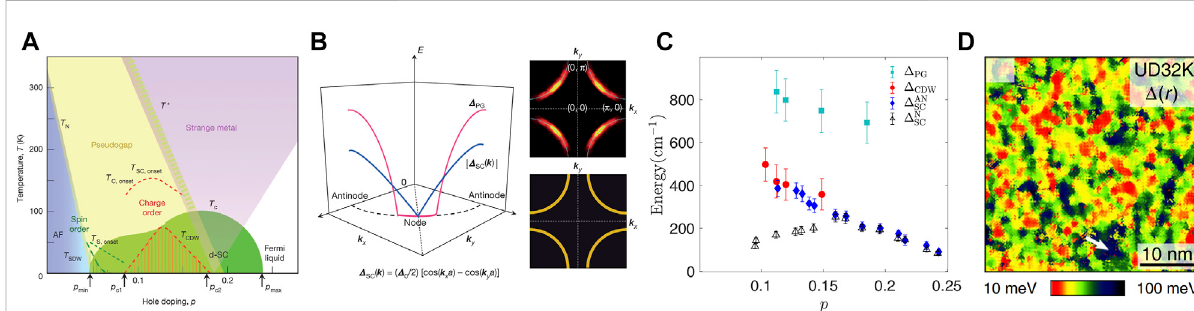
FIGURE 1 Pseudogap phenomena in cuprates. (A) The complex phase diagram for hole-doped cuprates [1], which shows the pseudogap phase and its associations with spin,charge, and superconducting orders. (B) Gapfunctions,Fermiarcs,and Fermisurface[1].Once thepseudogap( Δ PG intheleft panel) sets in, the antinodal regions of the Fermi surface near the Brillouin zone edge are gapped out, giving rise to Fermi arcs (top right). (C) The doping dependencies of the pseudogap, the antinodal superconducting, and the CDW energy scales in HgBa 2 CuO 4+ δ with data from Ref. [11]. (D) The local spectral gap of an underdoped sample of (Bi,Pb) 2 (Sr,La) 2 CuO 6+ δ measured by STM at each point, adapted from Ref. [42]. (A) and (B) are adapted from Ref. [1] with